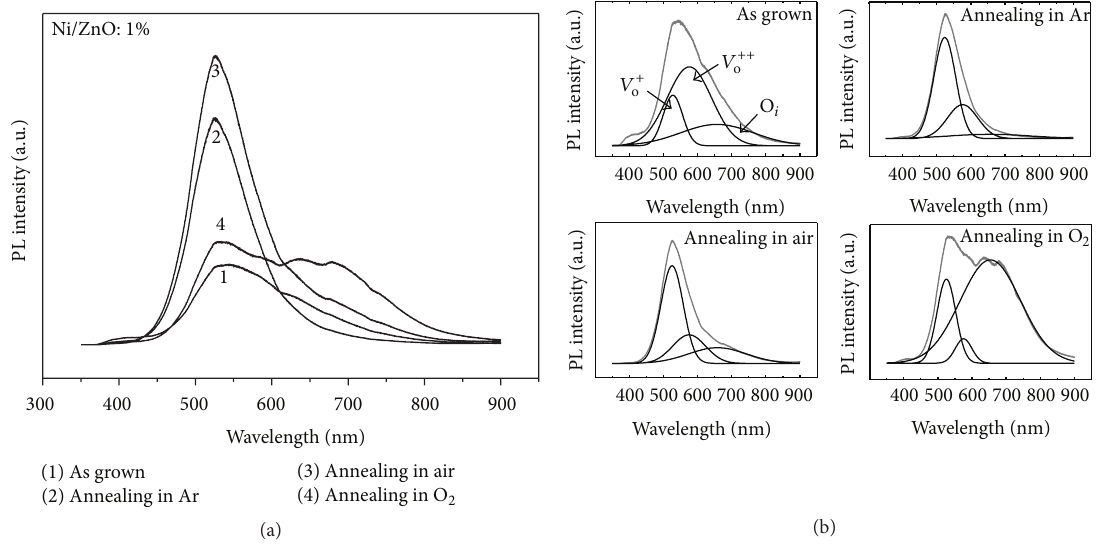
Figure 3: RT photoluminescence spectra of Ni doped ZnO samples as grown and annealed in different atmosphere (a) and Gaussian fit of each PL spectrum (b) (The gray lines are the experimental results and the black solid curves are Gaussian fits).